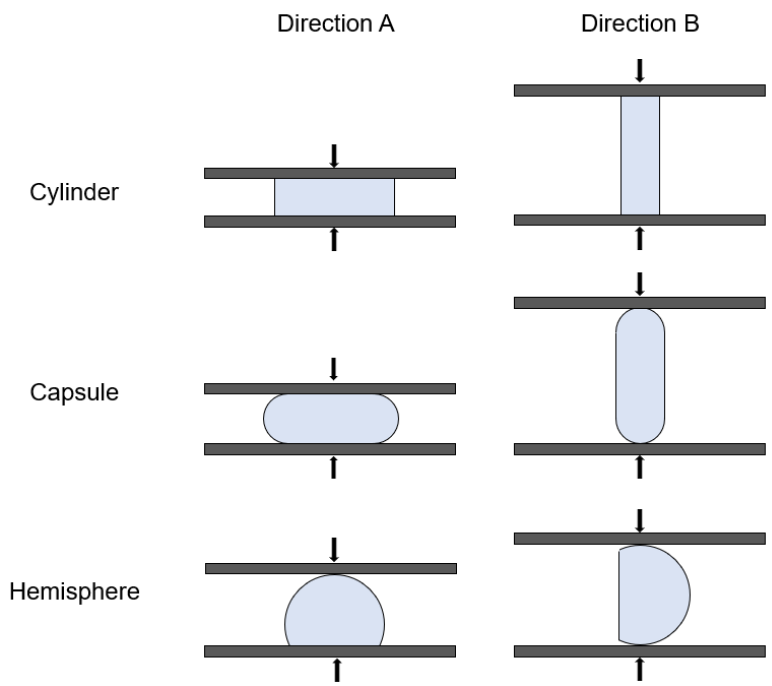
Figure 2. Illustration of the force applied to formulations in the hardness test.